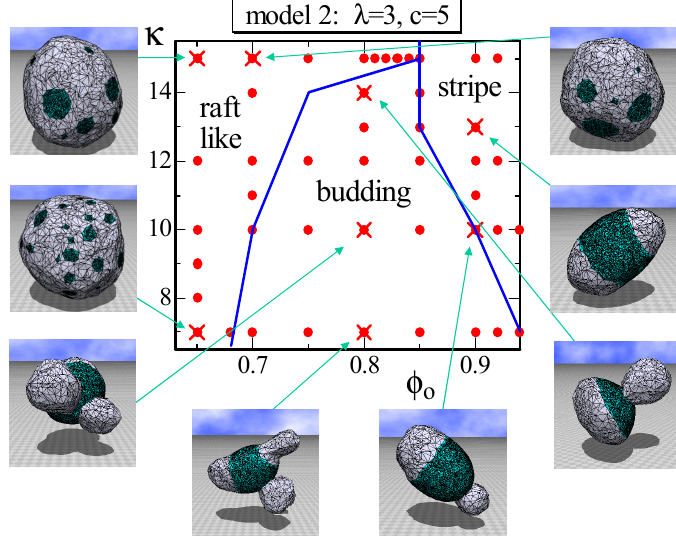
Figure 8. A phase diagram of Model 2 on the κ − φ o plane at λ = 3 and c = 5 and the snapshots of surfaces obtained at the points indicated by the symbol ( × ). The solid lines on the phase diagram denote the phase boundaries. The solid circles ( • ) denote the data points of the simulations for the phase